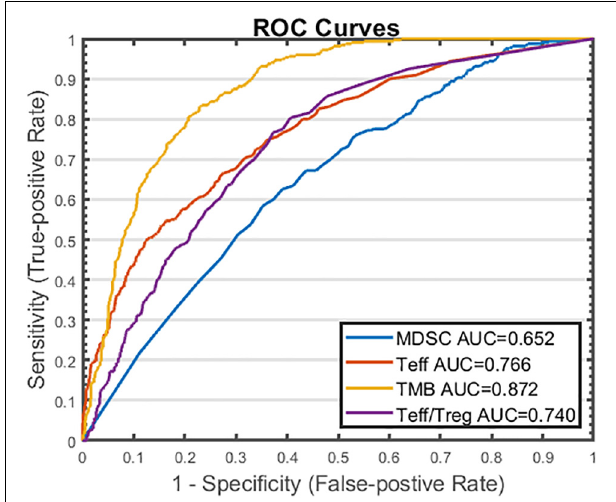
FIGURE 10 | ROC Analysis of Potential Predictive Biomarkers in Triple Combination Therapy. Cutoff values are selected based on the range of pre-treatment amounts of myeloid-derived suppressor cell (MDSC) density, effector T cell (Teff) density, tumor mutational burden (TMB), and Teff to regulatory T cell (Treg) ratio. For each cutoff value, response status (R vs. NR) is predicted for each virtual patient by comparing the pre-treatment amount of the potential biomarker to the cutoff value. Sensitivity (true positive rate) is plotted against 1 – specificity (true negative rate) for each biomarker. R, responders; NR,